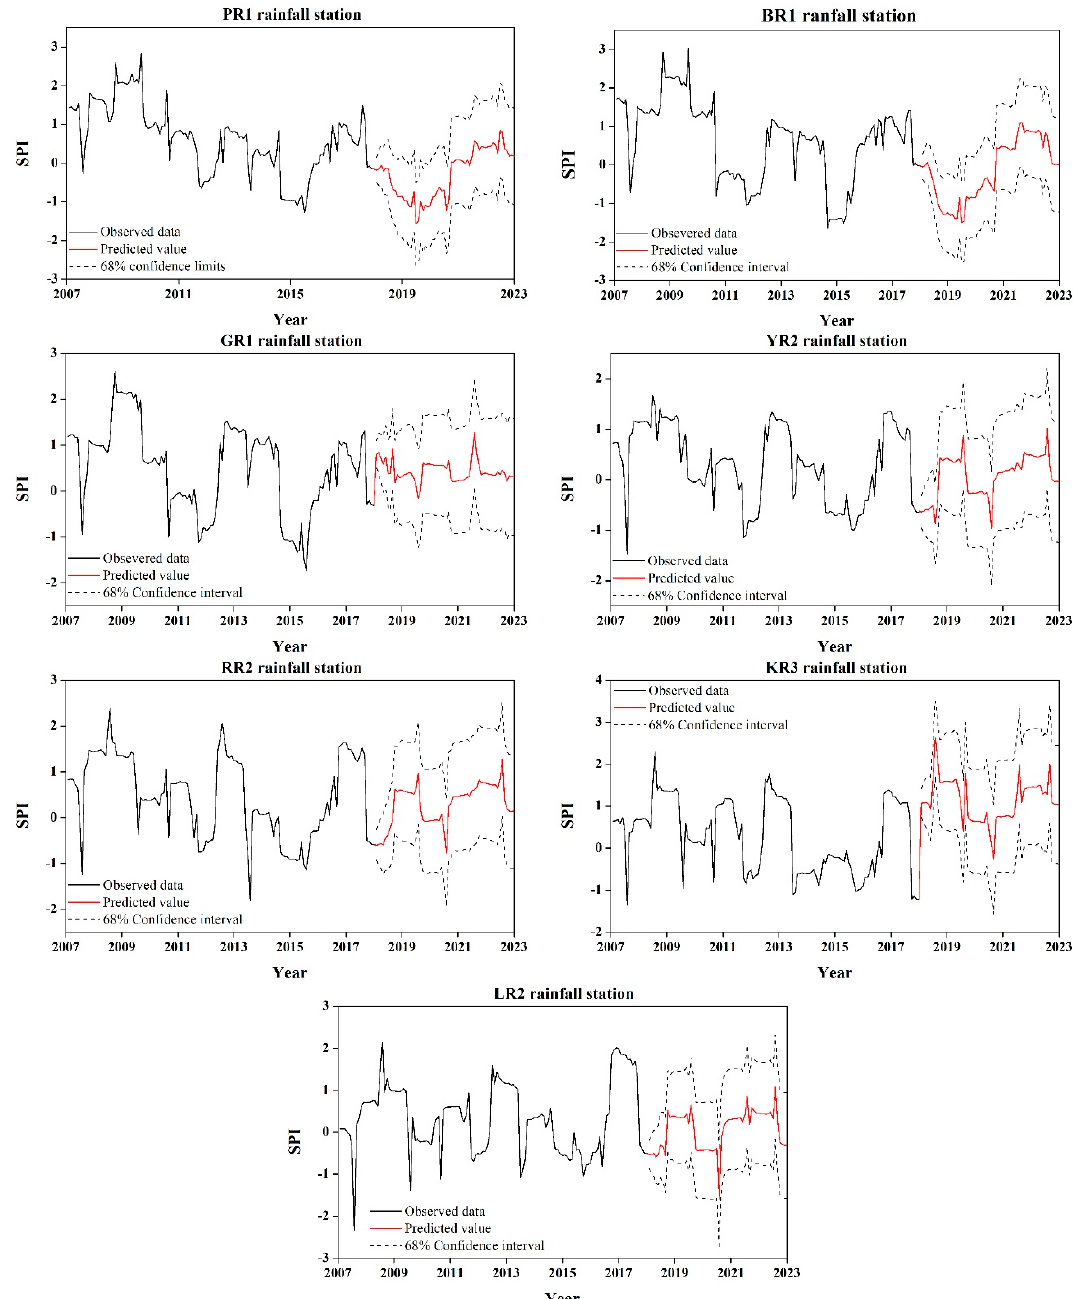
Figure 7. Drought forecasting for the period 2018–2022 using the seasonal ARIMA model at each basin.